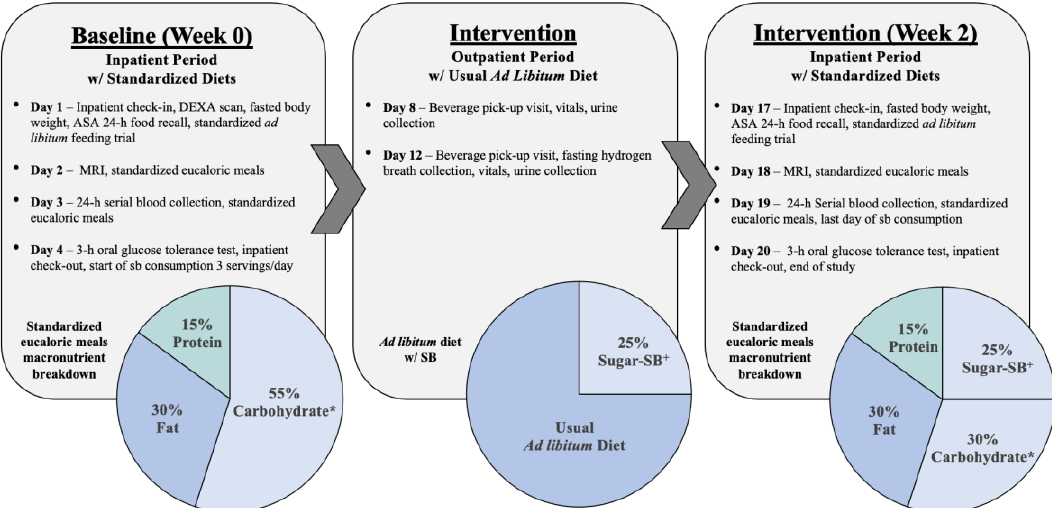
Figure 1. Study design, experimental testing days, and dietary protocol. Sweetened beverage (SB), dual energy X-ray absorptiometry (DEXA), automated self-administered 24-h (ASA 24-h) dietary assessment tool, high fructose corn syrup (HFCS). * < 2% added sugar. + Either 0% energy requirement (Ereq) as aspartame or 25% Ereq as glucose, fructose, HFCS or